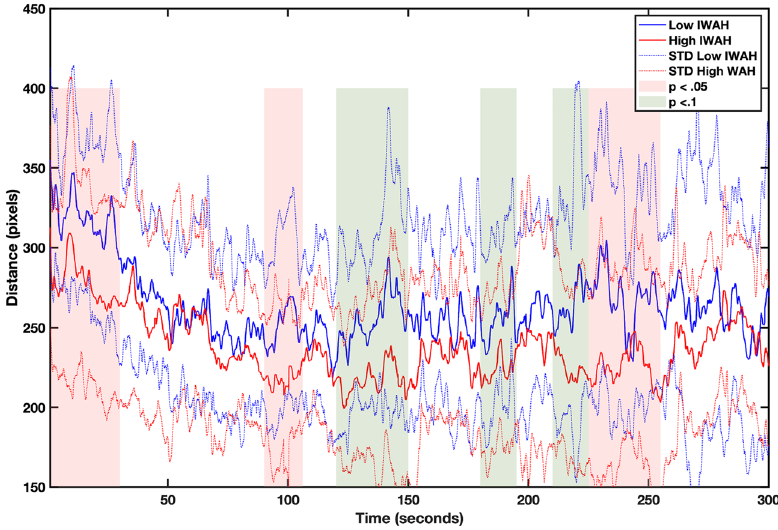
Figure 1. Average distance in pixels between participants and a lab assistant for the low-IWAH (blue) and the high-IWAH (red) groups. Differences in the distance were tested in blocks of 15 s. Significant differences ( p < 0.05) between distances are highlighted as red-shaded areas while trends ( p < 0.1) are highlighted as green- shaded